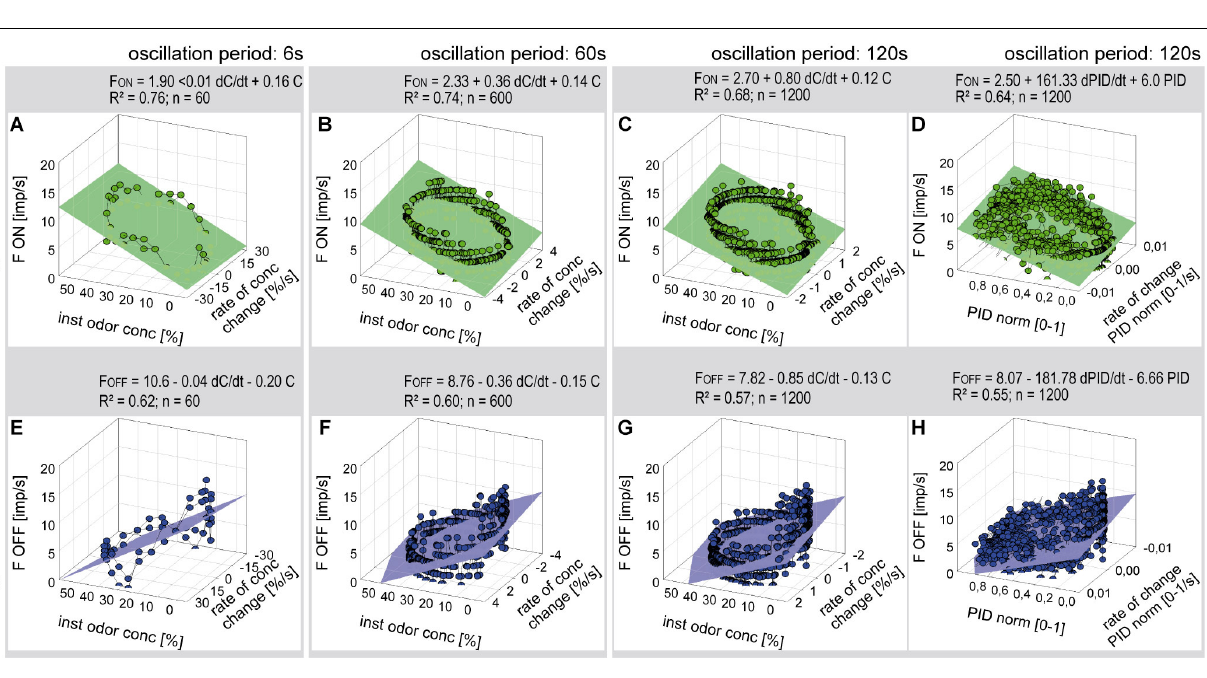
Frontiers in Physiology |